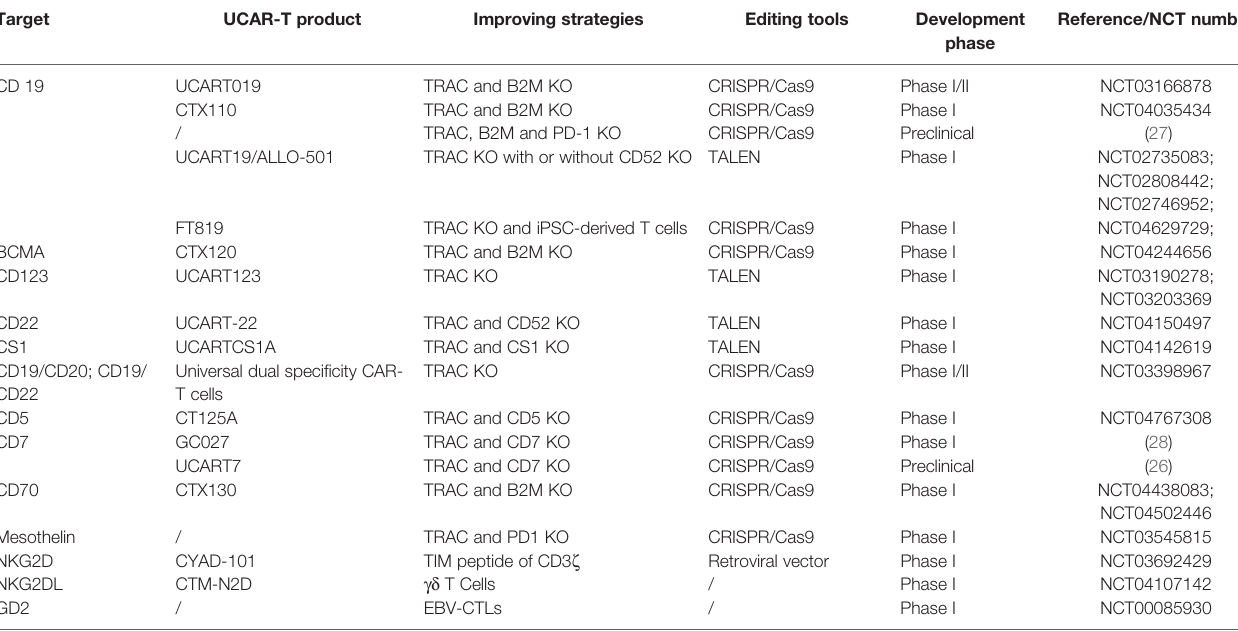
TABLE 2 | Summary of targets involved and strategies to improve the ef fi ciency in UCAR-T cell therapy. Target UCAR-T product Improving strategies Editing